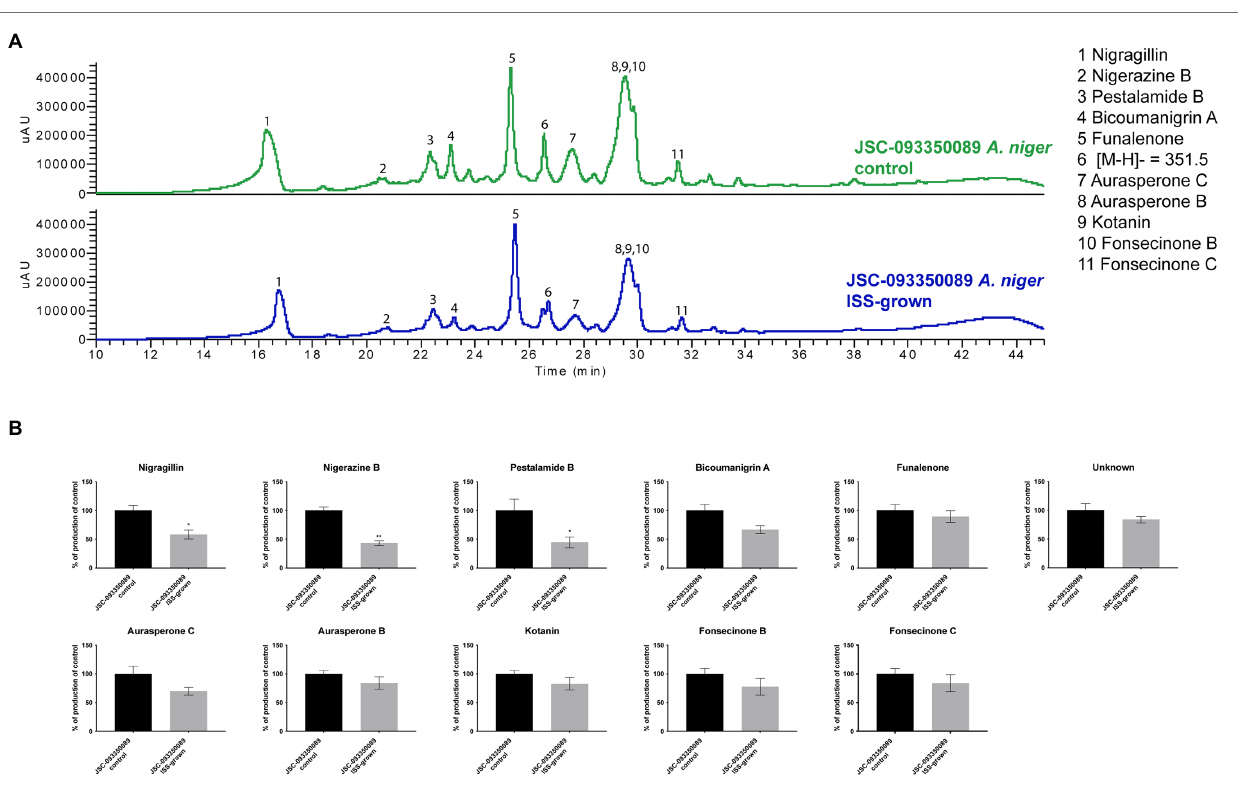
FIGURE 2 | Secondary metabolite production of ISS-grown JSC-093350089 when compared to ground controls. (A) Secondary metabolite profiles of ISS- and ground-grown JSC-093350089 when grown on GMM. (B) Metabolite quantification showing the percent change for each metabolite in relation to ground-grown JSC-093350089; significance was determined using Welch’s t-test. “*” means and indicates statistical